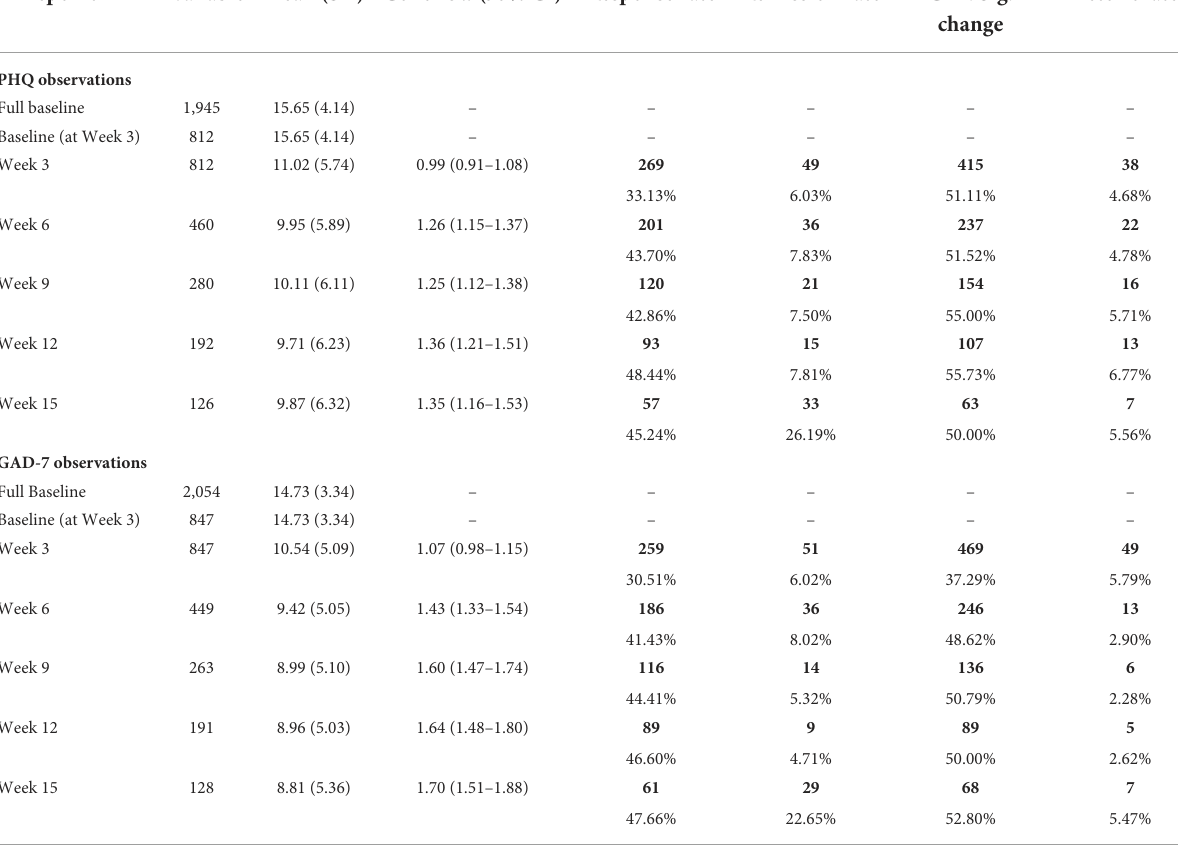
TABLE 2 Clinical outcomes for the older sample ( N =